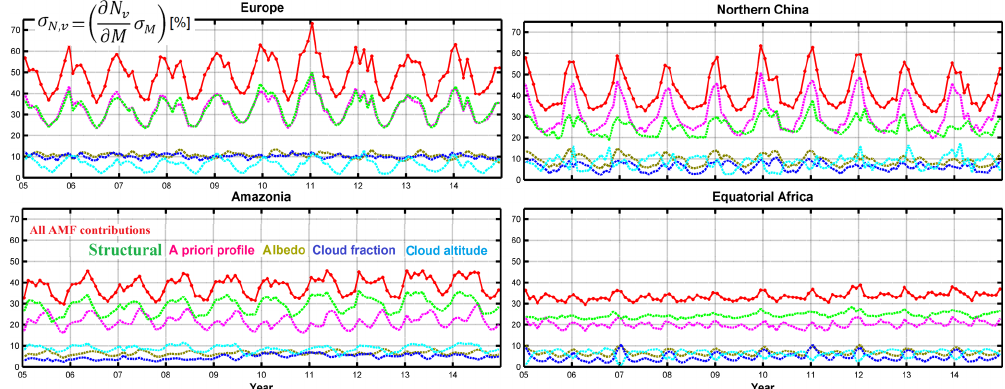
Figure 12. Regional and monthly average of the relative systematic vertical column AMF-related uncertainties in several NMVOC emission regions, for the period 2005–2014. The five contributions to the systematic air mass factor uncertainty are shown: structural (green), a priori profile (pink), albedo (olive), cloud fraction (blue), and cloud altitude